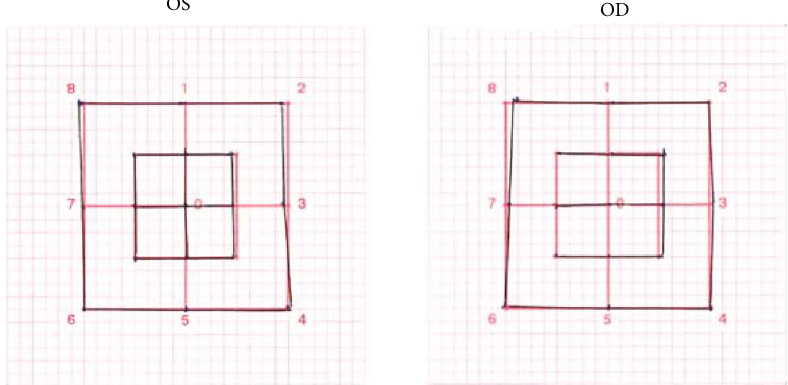
Figure 2: The Hess-Weiss test after cipro fl oxacin cessation. Abbreviations: OS, oculus sinister, left eye; OD, oculus dexter, right